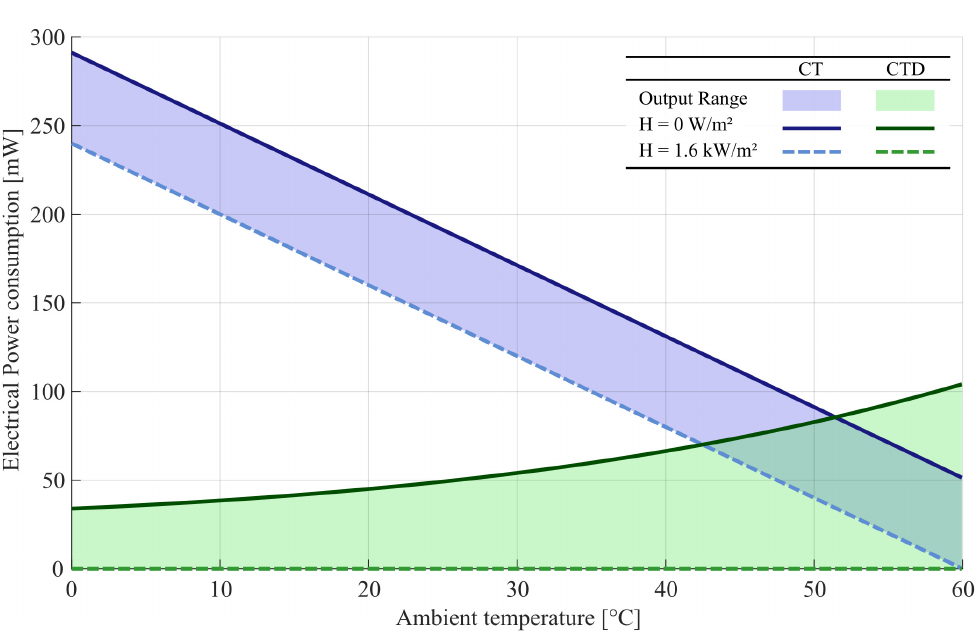
Figure 8. The power consumption from a sense branch in CT and CTD Wheatstone bridge